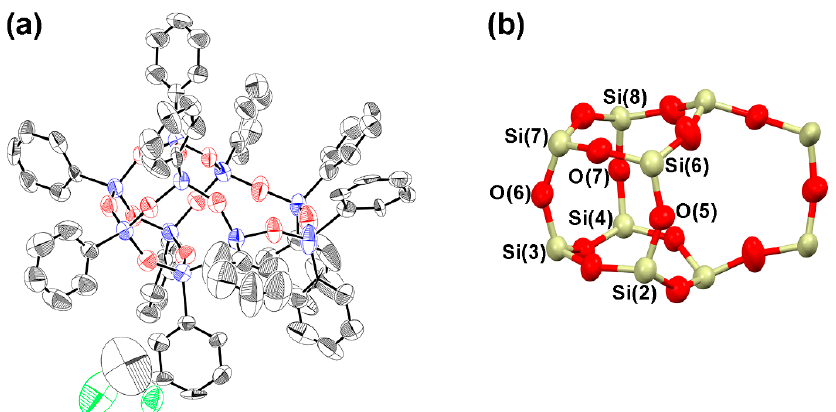
Figure 2. X-ray crystallography data. ( a ) ORTEP (Oak Ridge Thermal- Ellipsoid Plot Program) diagram of 3 in perspective view. Ellipsoids are drawn at the 30% probability level. Hydrogen atoms are omitted for clarity. Black: carbon; blue: silicon; red: oxygen; green: chlorine. ( b ) Side view of 3 with number labels. Hydrogen atoms and phenyl rings are omitted for clarity. Yellow: silicon; red: oxygen.